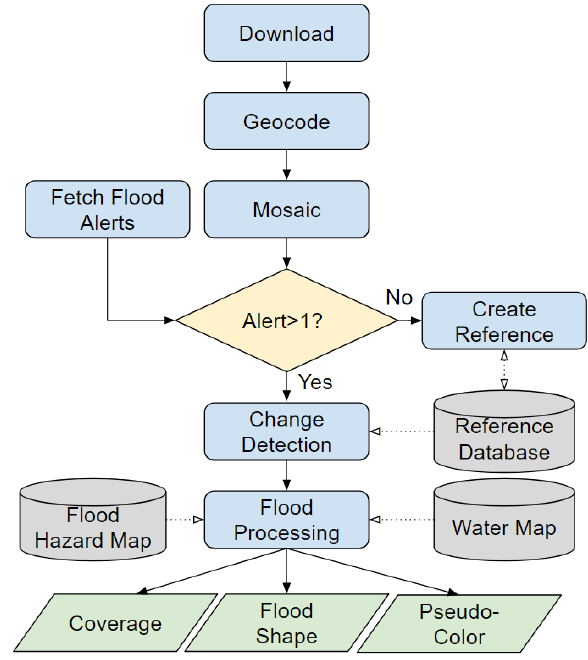
Figure 1. Overview of the flood-detection processing chain. The flood-detection processing chain (Figure 1) is fully auto-